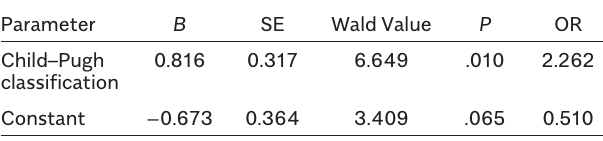
Table 2. Baseline Model Analysis